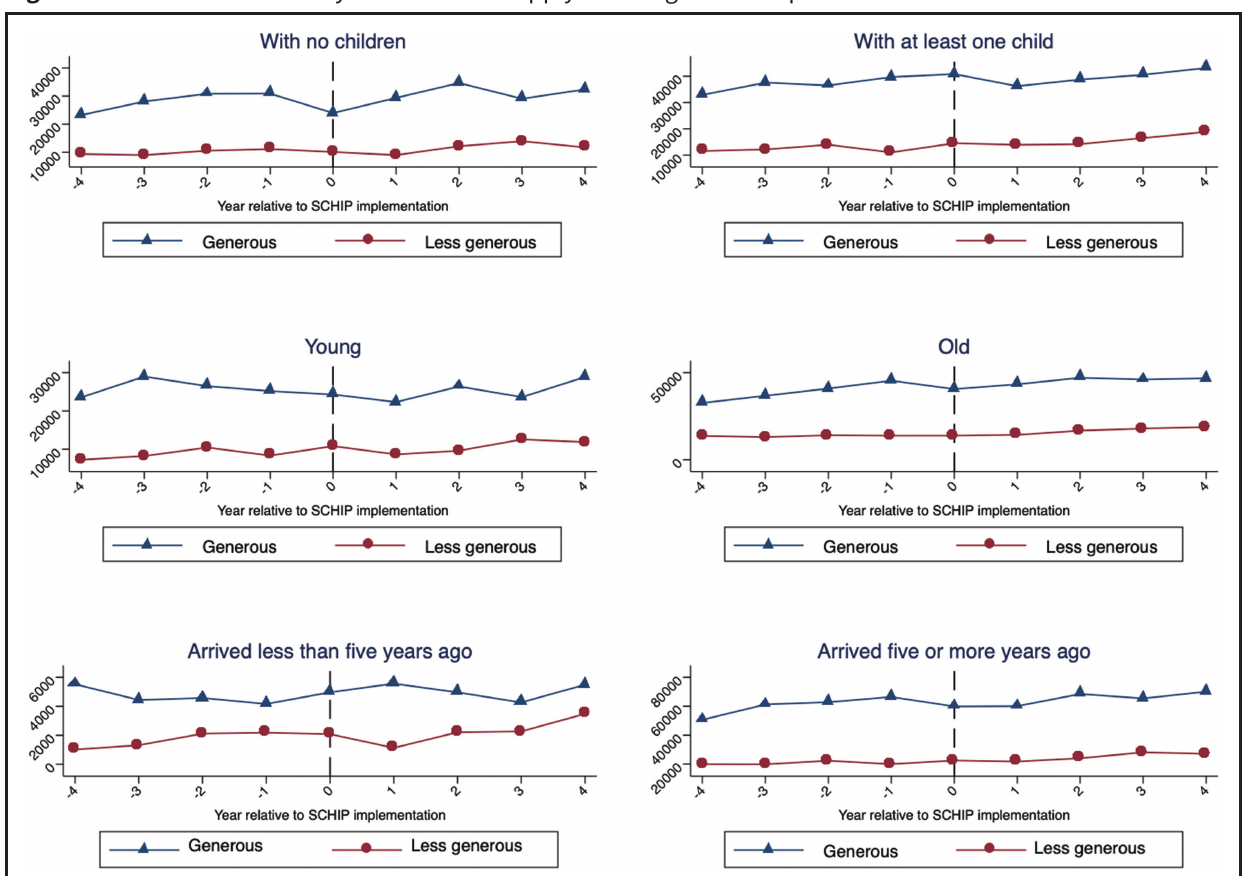
Pre- and Post-Policy Trends in the Supply of Immigrant Entrepreneurs with Various